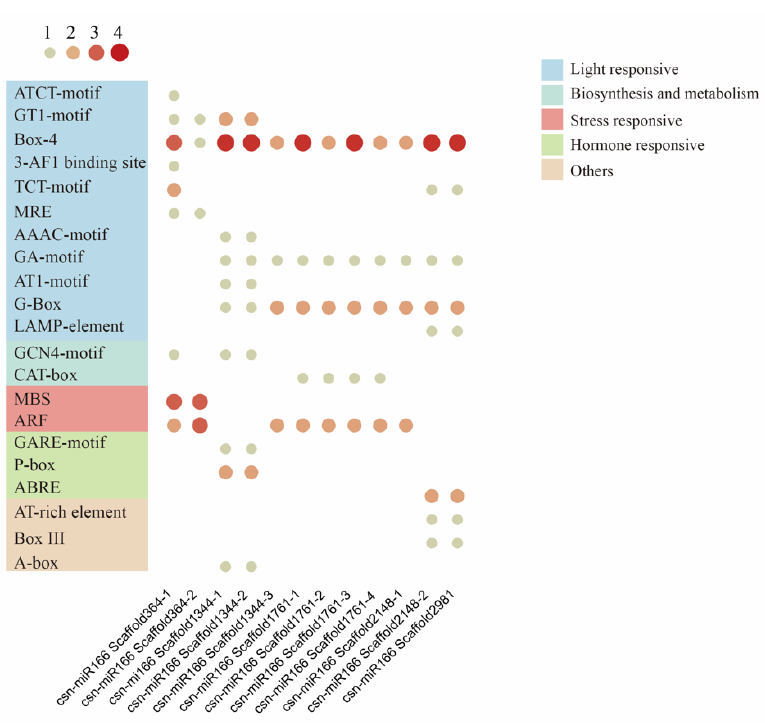
Figure 5. Promoter analysis of MIR166 genes in Camellia sinensis (L.) O. Kuntze.